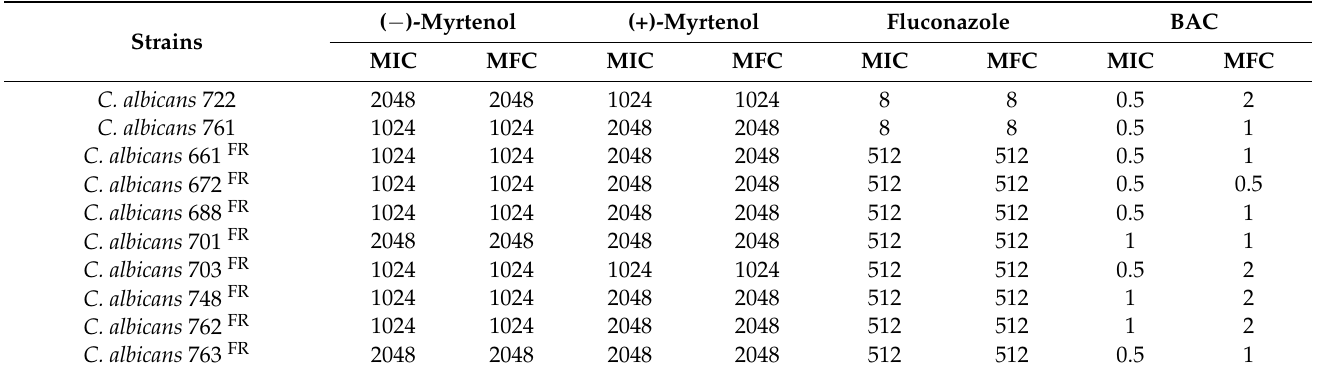
Table 2. Minimum inhibitory concentration (MIC) and minimum fungicidal concentration (MFC) (expressed in µ g/mL) of ( − )-myrtenol, (+)-myrtenol, fluconazole and benzalkonium chloride (BAC) against C. albicans